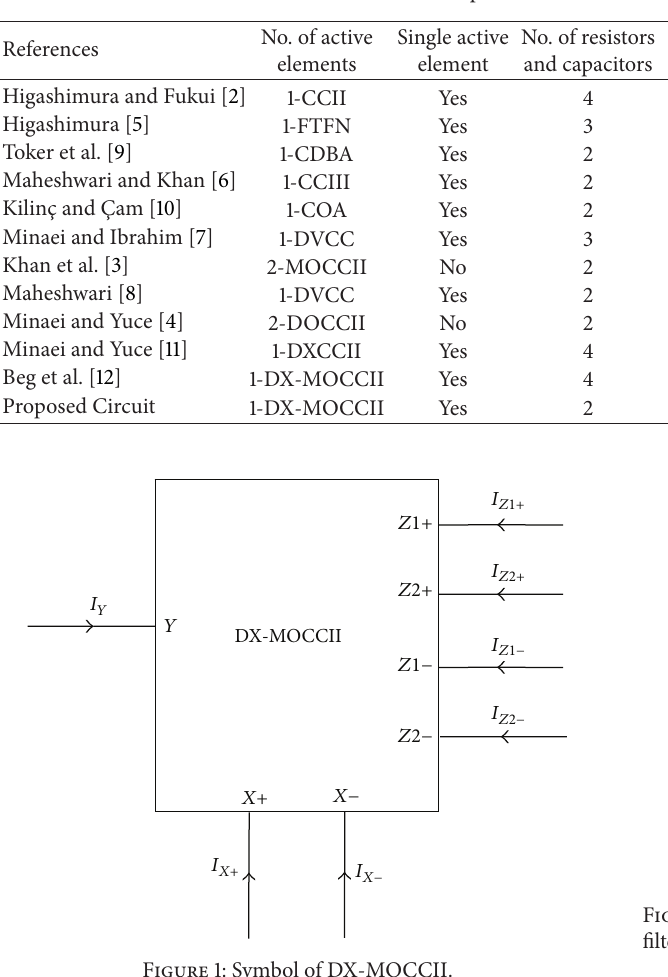
Figure 1: Symbol of DX-MOCCII.